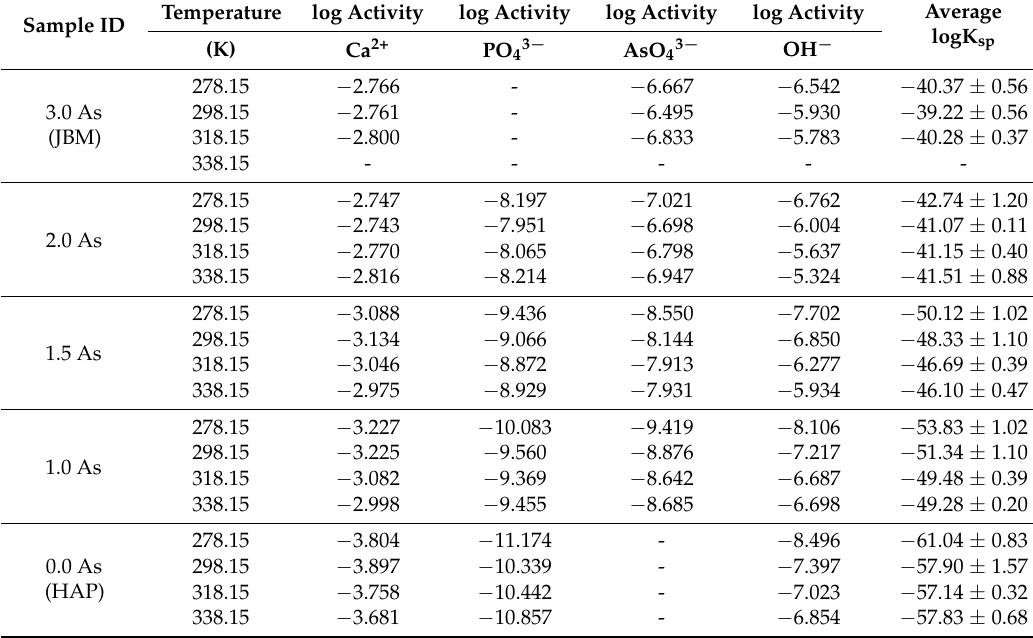
Table 4. Equilibrium activities and average solubility product determined experimentally from dissolution at various temperatures and atmospheric